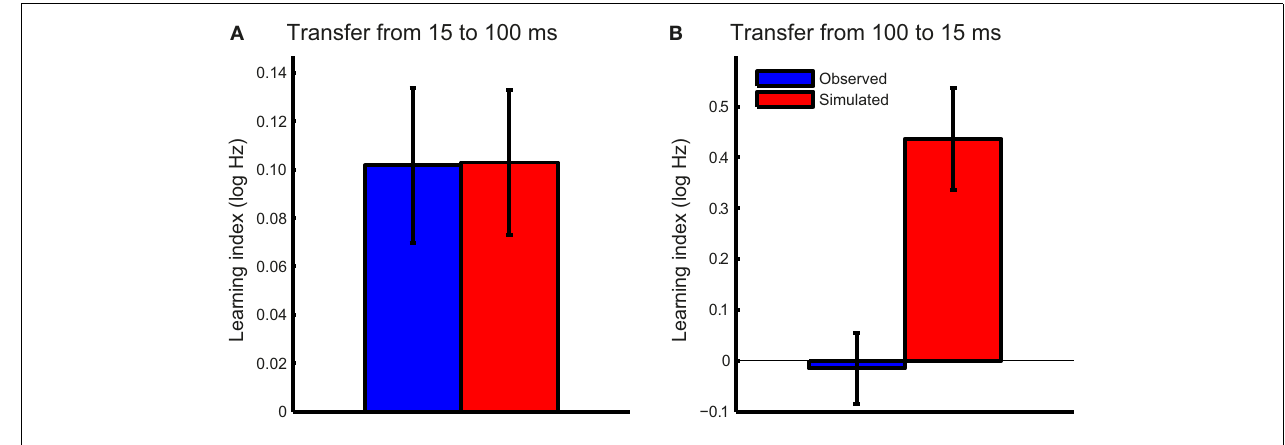
on improved phase locking (red bars) were plotted for (A) theT15 and (B) the T100 training groups. Error bars indicate ± 1